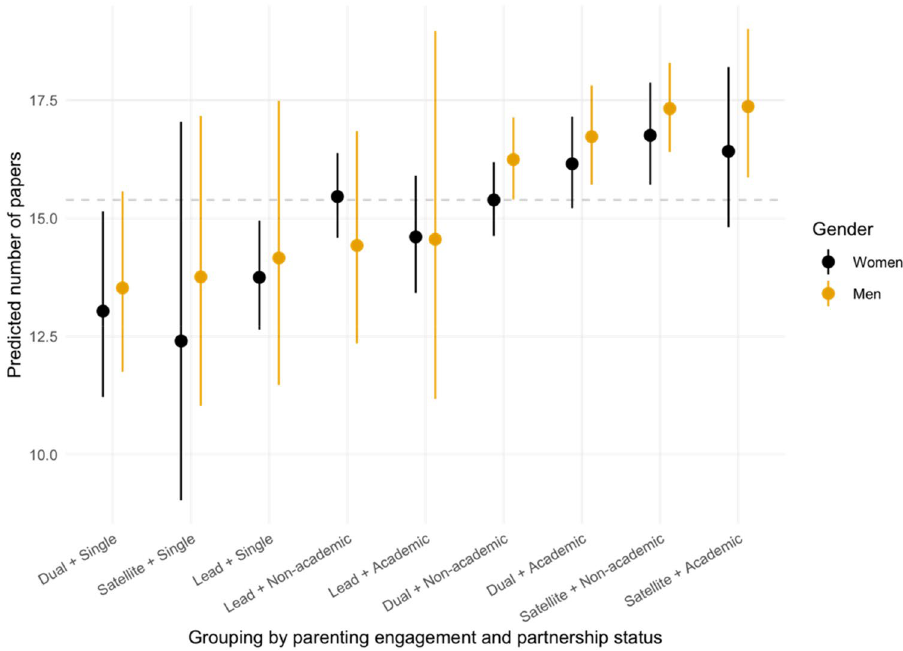
Figure 3. Predicted number of papers for men and women, by parenting engagement and partnership status. The dash line refers to the predicted productivity of our reference group: dual mothers with a non-academic partner. Results are averaged over the levels of number of children, academic employment status, doctoral degree, and domain. Intervals are back-transformed from the log